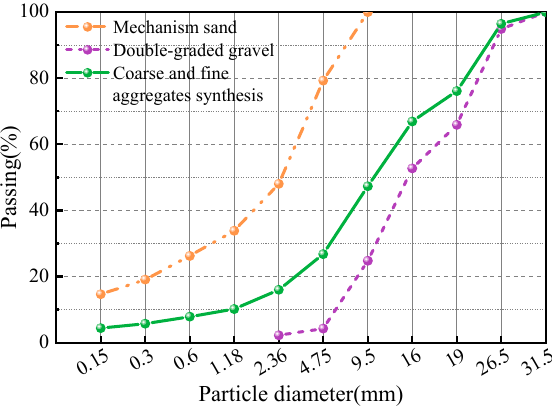
Figure 2. Granulometric curves for the fine and coarse aggregate. Table 4. Physical and mechanical properties of POM fiber.